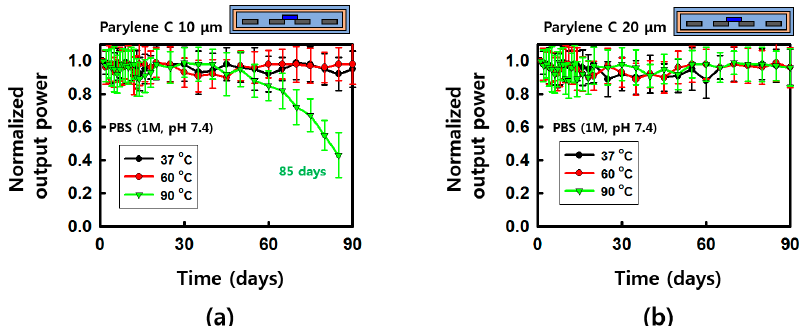
infrared image of the bottles and hot plates during the time test.